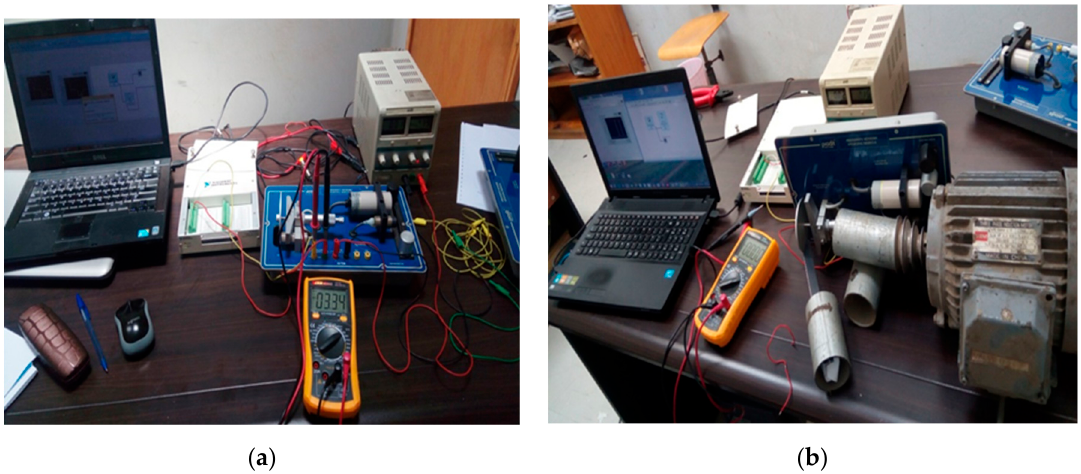
Figure 6. ( a ) Setup for calibration. ( b ) Laboratory setup where complete data acquisition system is mounted to perform various experiments.